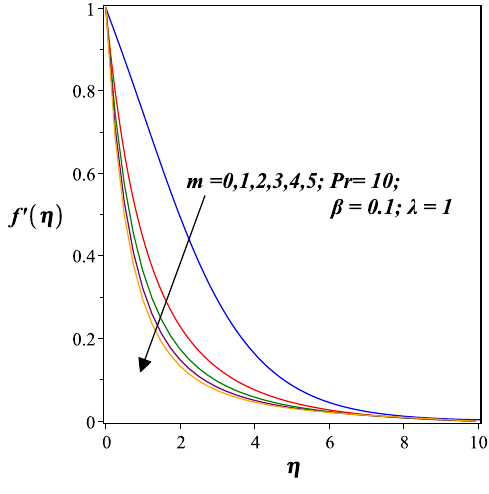
Figure 1. Effect of parameter m on the dimensionless velocity along horizontal wall for V c = −